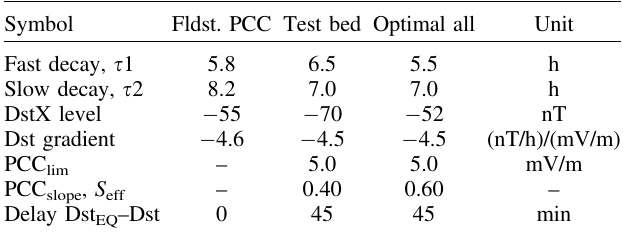
Table 3. Parameters for Dst EQ